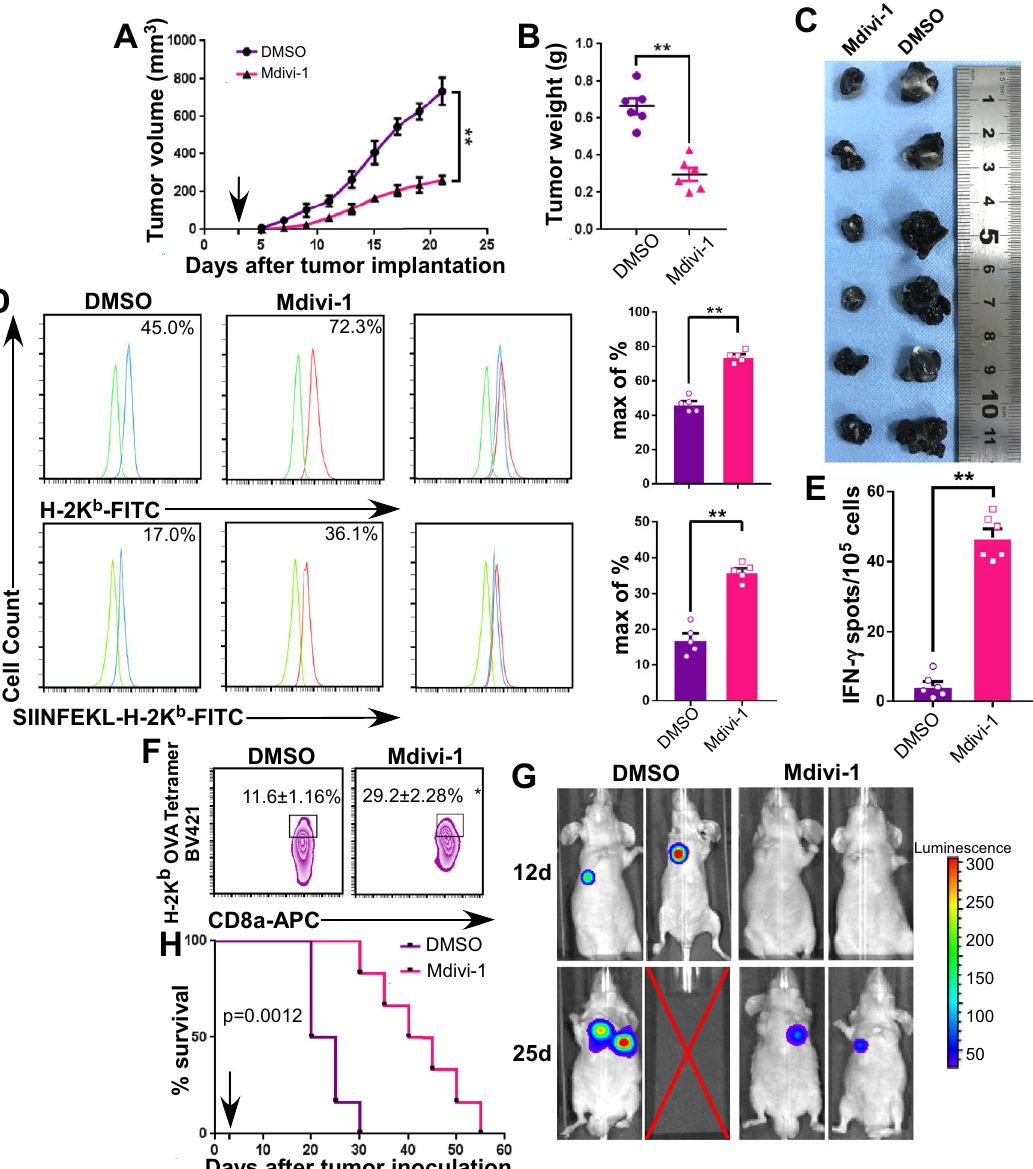
Fig. 2 Mdivi-1 mediates MHC-I expression in syngeneic tumor models. A Tumor volume measurements after subcutaneous implantation, arrow indicates the time of Mdivi-1 or DMSO treatment (mean ± s.e.m; n = 6; p = 0.0124; ** p < 0.001 by two-way ANOVA followed by Dunnett ’ s tests for multiple comparisons). B Weights of harvested tumors ( n = 6; p < 0.001; ** p < 0.001 by two-tailed t -test). C Photograph of harvested tumors. D